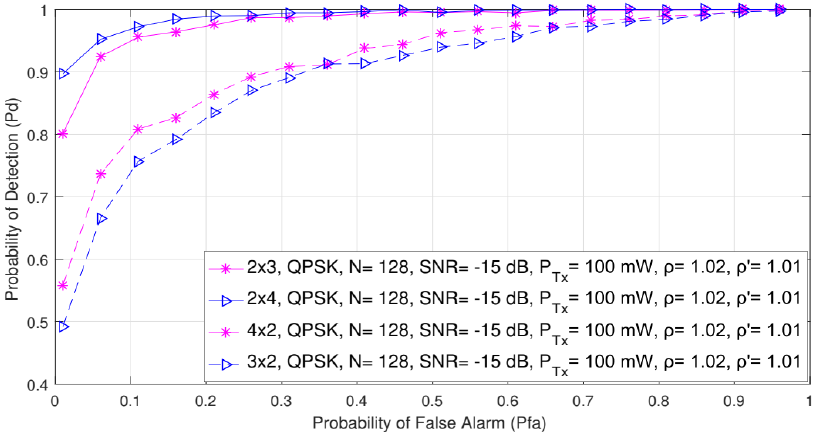
Figure 8. The ROC curves presenting the ED performance for the asymmetric 2 × 3, 2 × 4, 4 × 2 and 3 × 2 MIMO-OFDM communication systems.